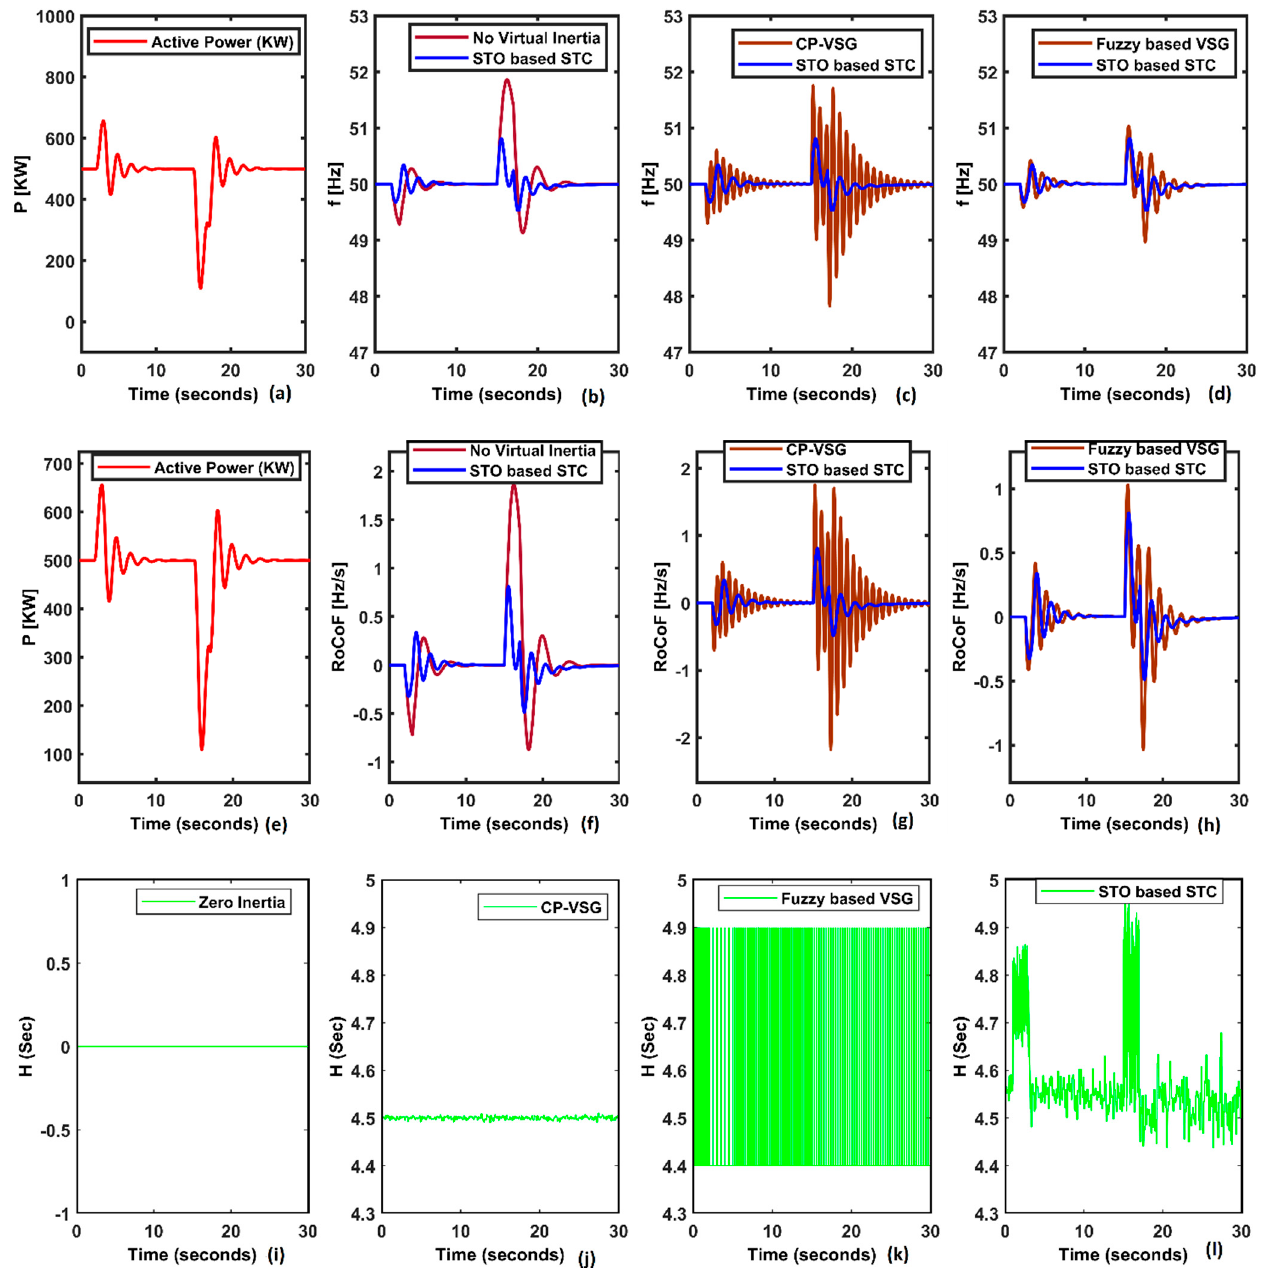
Figure 6. Grid-connected mode. ( a ) Active power variation, ( b – d ) dynamic frequency response of Grid-connected various control schemes, ( e – h ) rate of frequency variation for various control schemes, ( i – l ) inertia emulation.